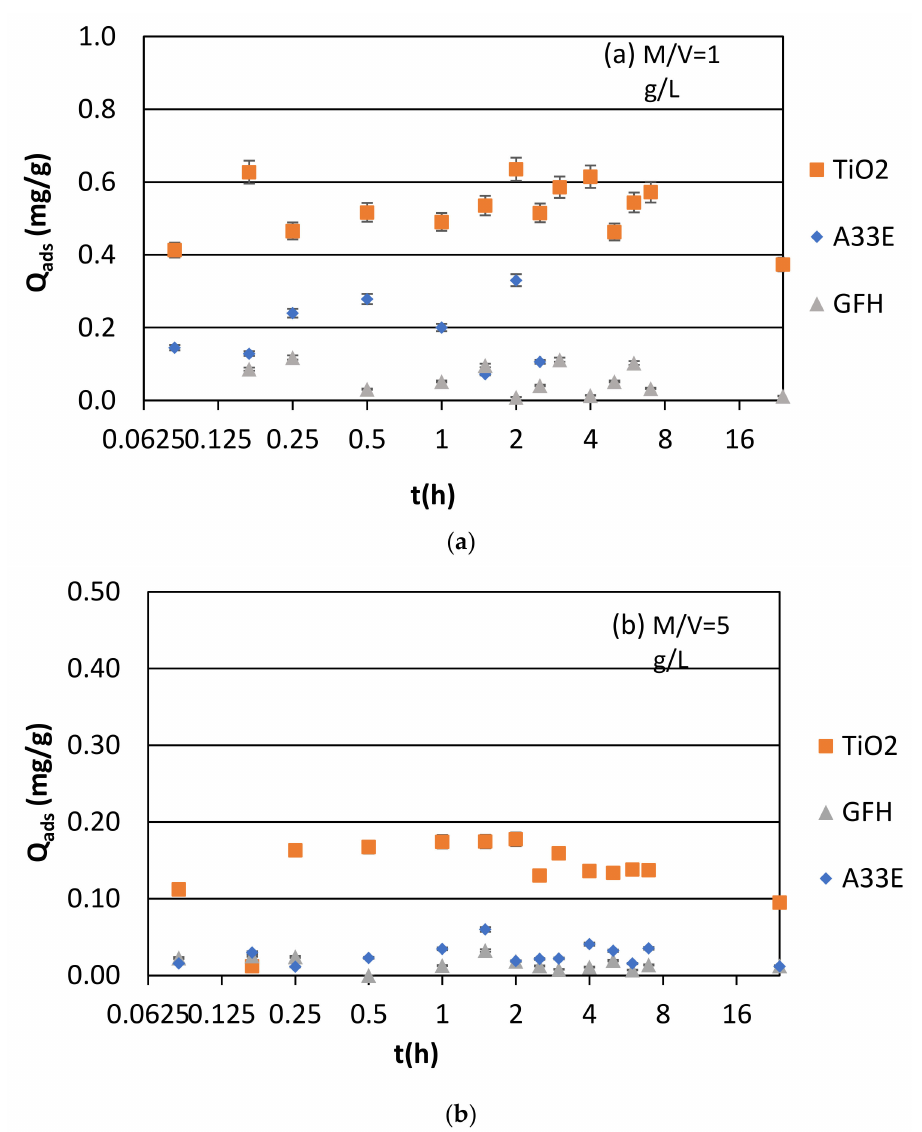
Figure 3. Adsorption capacity in real samples at different adsorbent dosages: ( a ) M/V = 1 g/L; ( b ) M/V = 5 g/L (measured pH = 8.0). The error bars indicate the standard deviation of the analytical